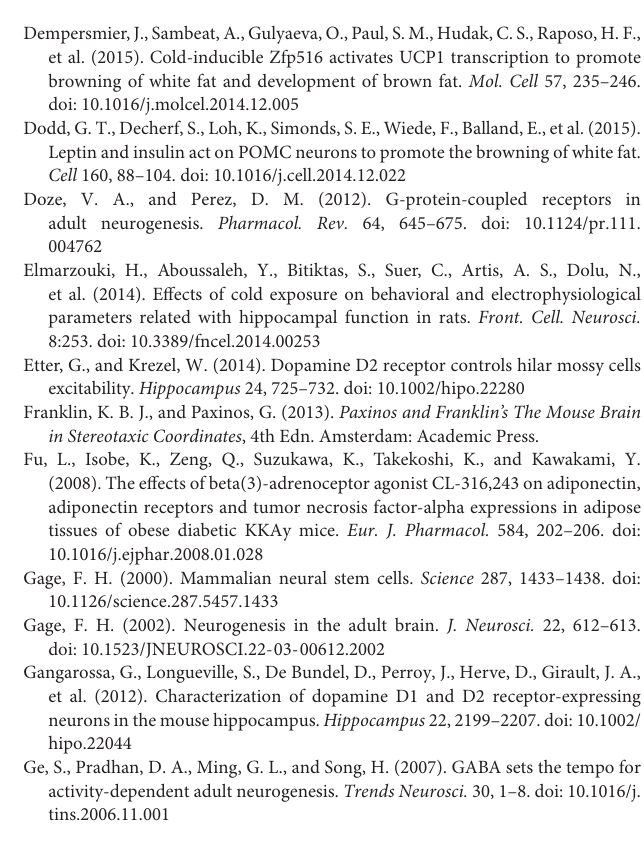
FIGURE S1 | Effects of 1 week CL 316,243 treatment on the expression levels of mRNA related to AHN, AHN-related signal transduction, and β -adrenergic receptor. There were no significant differences in gene expression levels of (A) early growth response, (B) neuronal migration, (C) neuronal differentiation, (D) cell fate determination and other regulators of cell differentiation, (E) regulation of synaptic plasticity and synaptic transmission, (F) synaptogenesis and axonogenesis, (G) AHN-related to signaling transduction, and (H) β -adrenergic receptor. FIGURE S2 | Effects of 4 weeks CL 316,243 treatment on the expression levels of mRNA related to AHN, AHN-related signal transduction, and β -adrenergic receptor. There were no remarkable changes in mRNA expression levels of (A) early growth response, (B) neuronal migration, (C) neuronal differentiation, (D) cell fate determination and other regulator of cell differentiation, (E) regulation of synaptic plasticity and synaptic transmission, (F) synaptogenesis and axonogenesis, (G) AHN-related to signaling transduction, and (H) β -adrenergic receptor. TABLE S1 | t - and p -values from statistical analysis of qRT-PCR